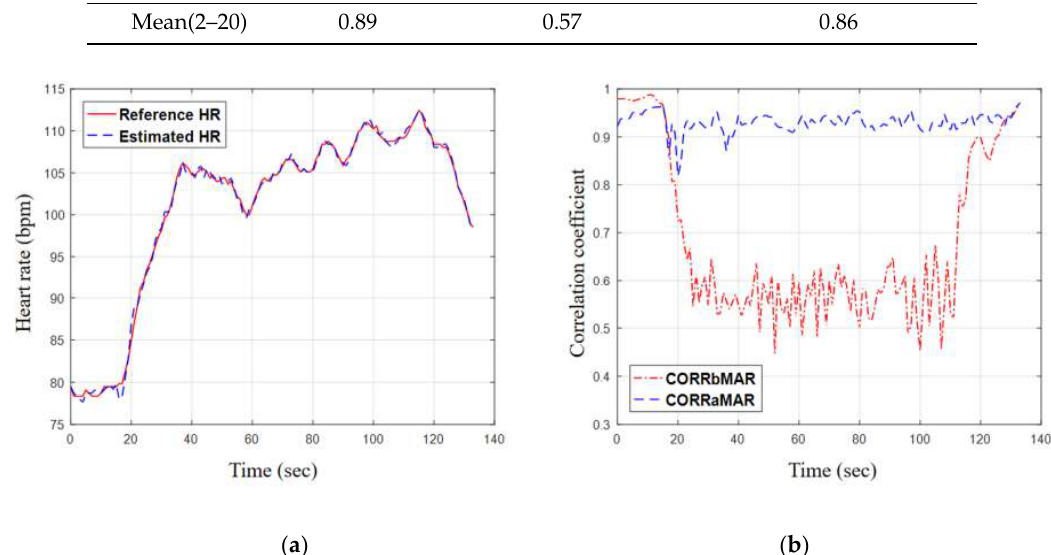
Figure 9. Taking subset 19 (the best case) for example to further analysis: ( a ) the contrast curves of HR estimation results and the reference HR values; ( b ) correlation curves against time.